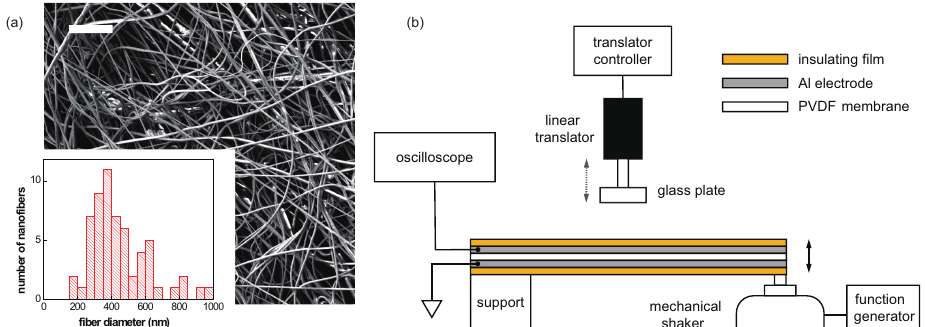
Figure 2. ( a ) Scanning electron micrograph of the electrospun PVDF nanofibers. (The scale bar on the top left corner is 10 µ m.) The lower inset shows the histogram of the nanofiber diameter distribution with a mean value around 450 nm. ( b ) Illustration of the experimental setup. The sensing element is composed of the piezoelectric PVDF membrane, sandwiched between Al electrodes and protective insulating films. One end of the sensing element is fixed on a support structure and the other end is connected to a mechanical shaker. While the membrane is driven to oscillation, the resulting piezoelectric voltage is monitored with an oscilloscope. To observe the piezoelectric response of the membrane under the static external load, the mechanical contact is established by approaching the glass plate, attached to a linear translator, onto the PVDF